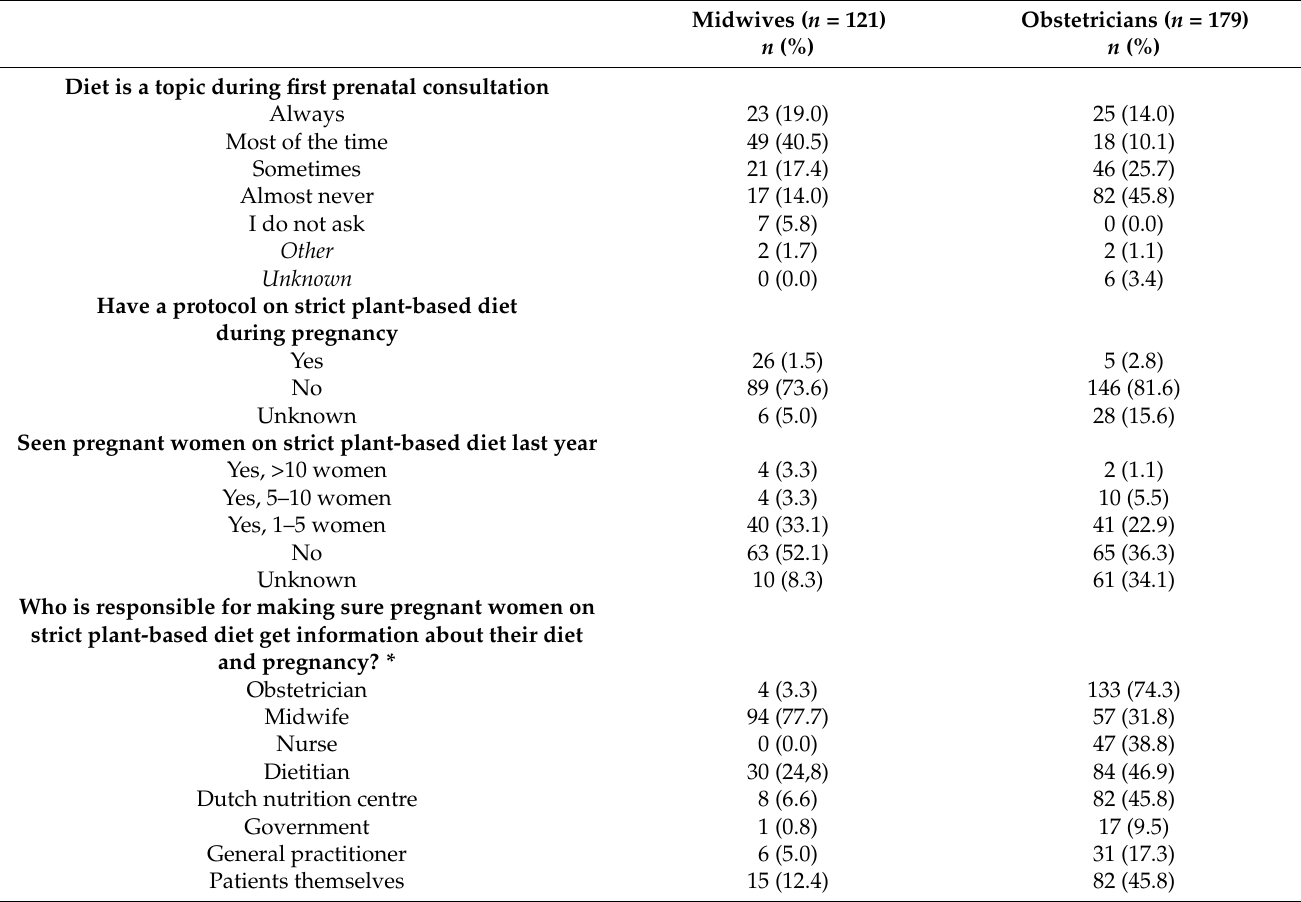
Table 2. Opinions of midwives and obstetricians on nutrition and a plant-based diet during